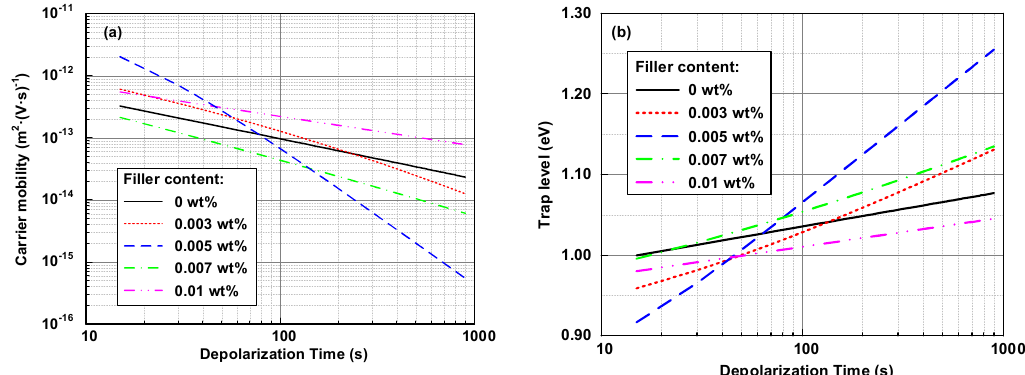
Figure 8. ( a ) Carrier mobility and ( b ) trap level of graphene/LDPE composites with different filler content at the shorted-circuit condition at 60 °C.